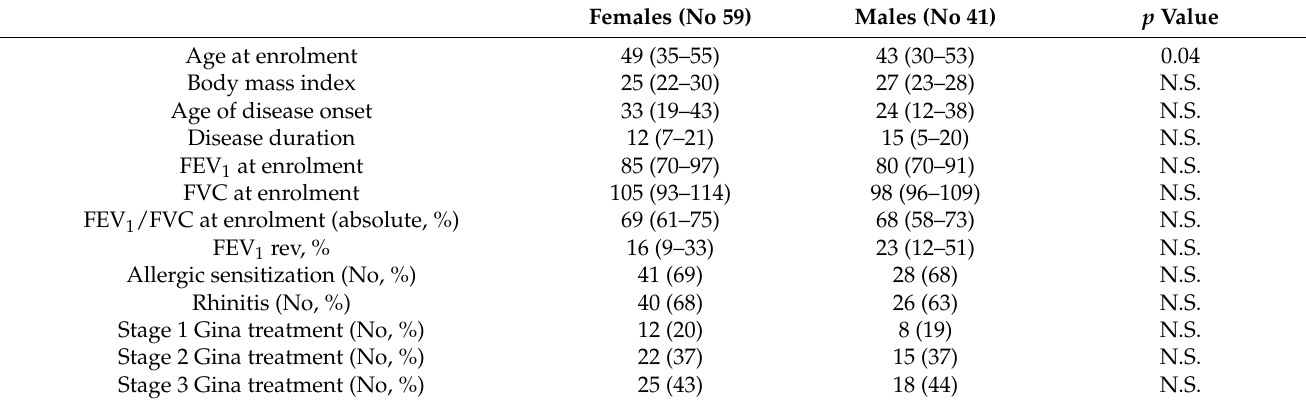
Table 1. Anthropometric, clinical, and pulmonary functional characteristics at enrolment, according to sex.